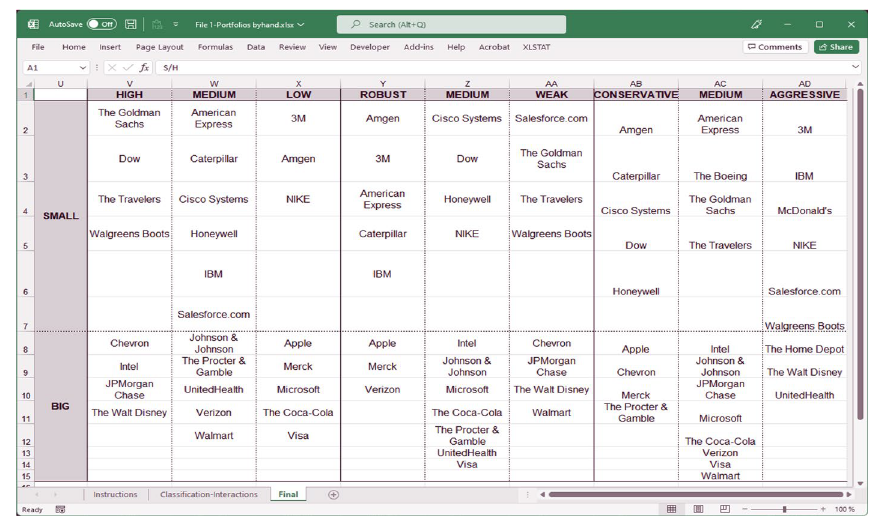
Fig. 4 Companies for portfolio formation. Source : Created by authors